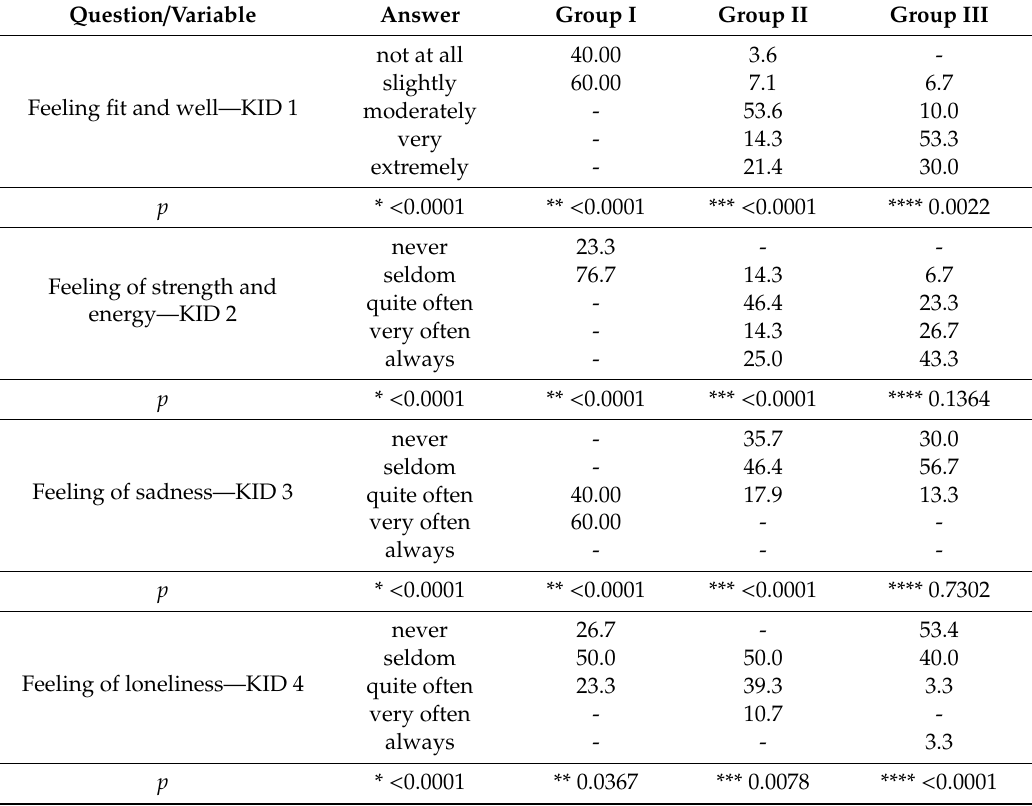
Table 6. Self-assessment of physical and mental health (KIDSCREEN). The percentage of respondents providing a given answer